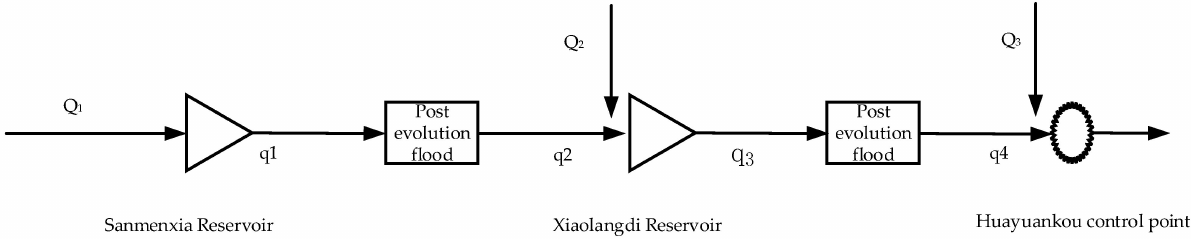
Figure 5. Flood evolution